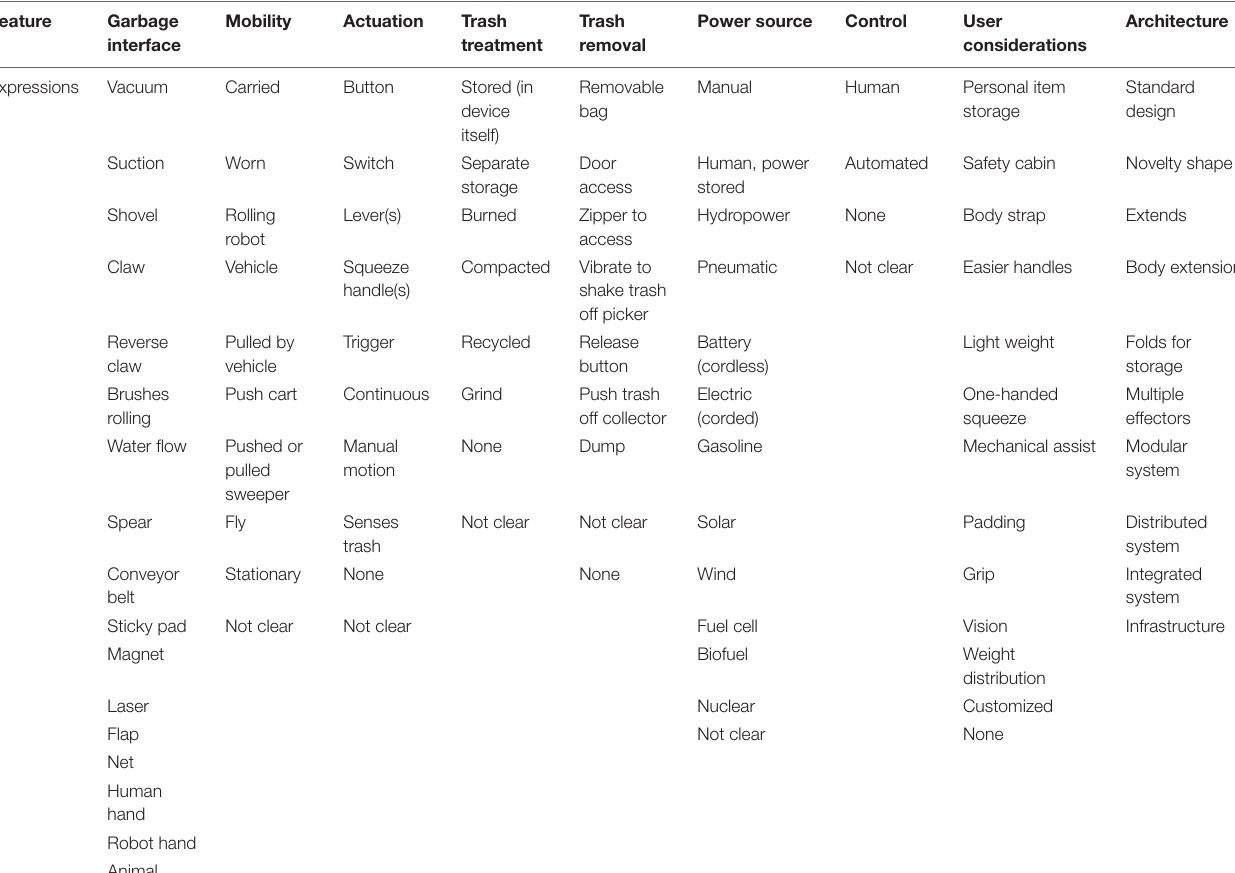
TABLE 2 | Litter collection system features and their expressions for novelty